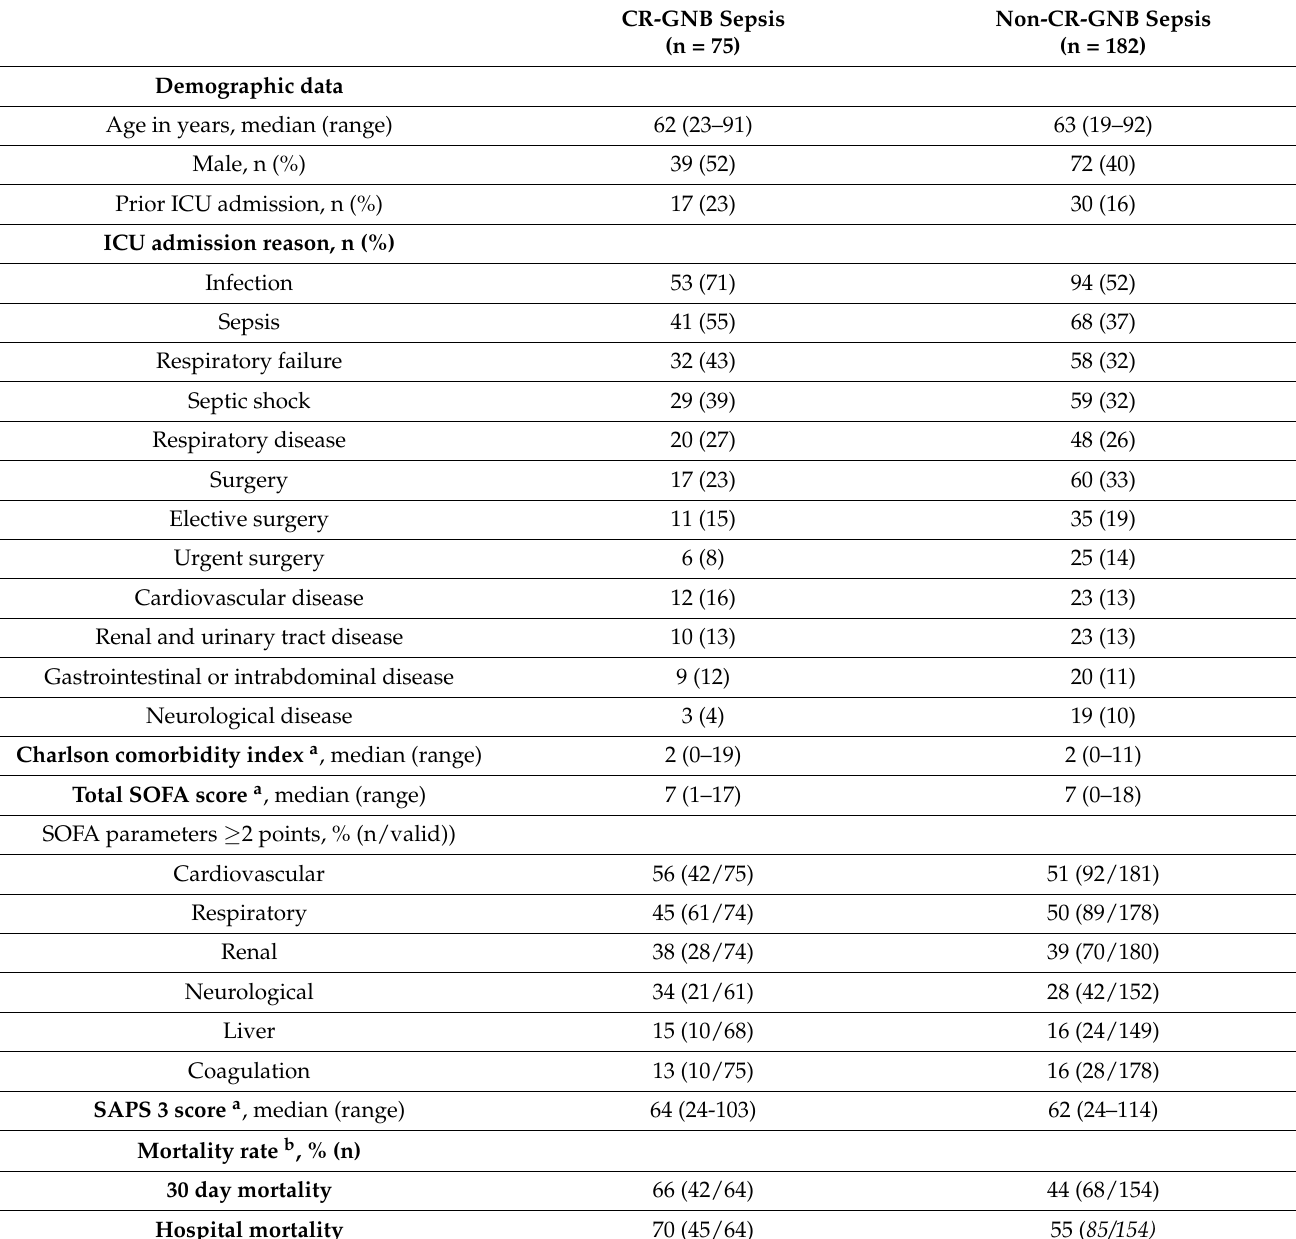
Table 1. Clinical and demographic characteristics of patients with episodes of CR-GNB sepsis and sepsis due to another or undetermined etiology (non-CR-GNB sepsis). CR-GNB